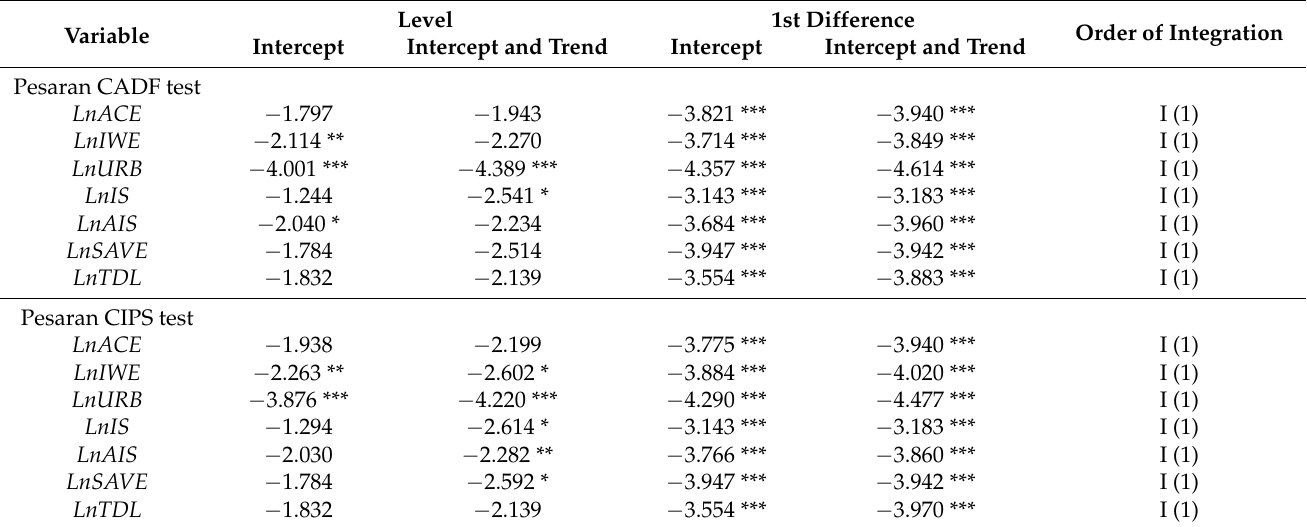
Table 3. Panel stationarity